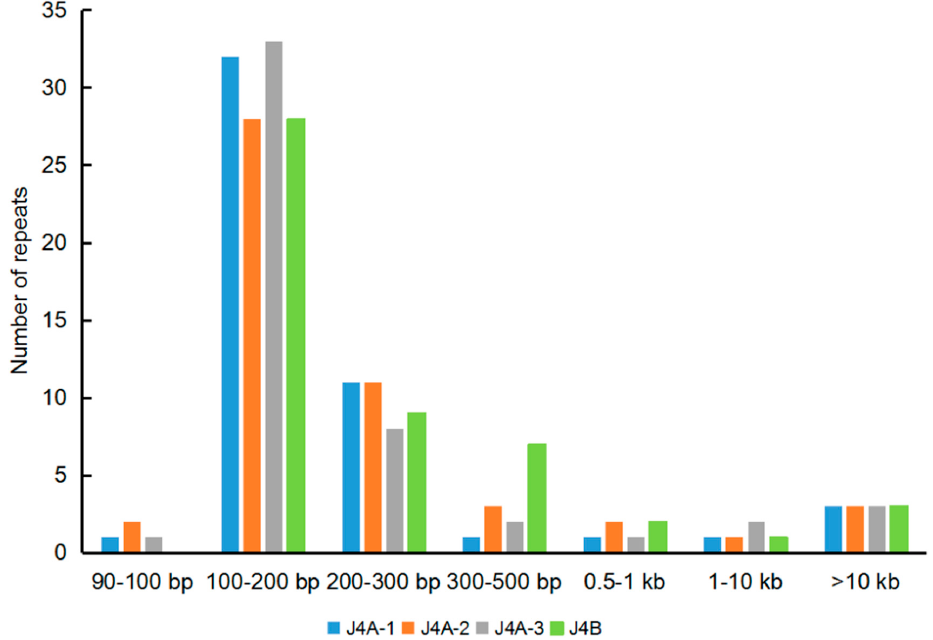
Figure 2. The number of repeat sequences of different sizes. Note: The X axis shows the repeat